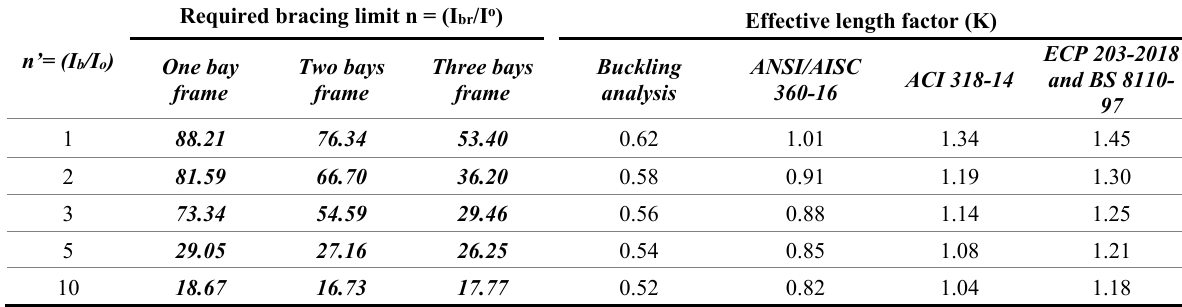
Table 3. Required bracing limit and effective length factors for the three-stories frames.